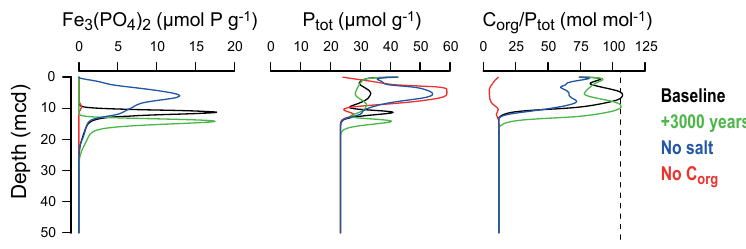
Figure 12. Sensitivity of vivianite, total P concentration and the C org :P ratio in the sediments to changes in salinity and productivity from 12000 years BP to present, as well as 3000 years in the future with the current parameterization.